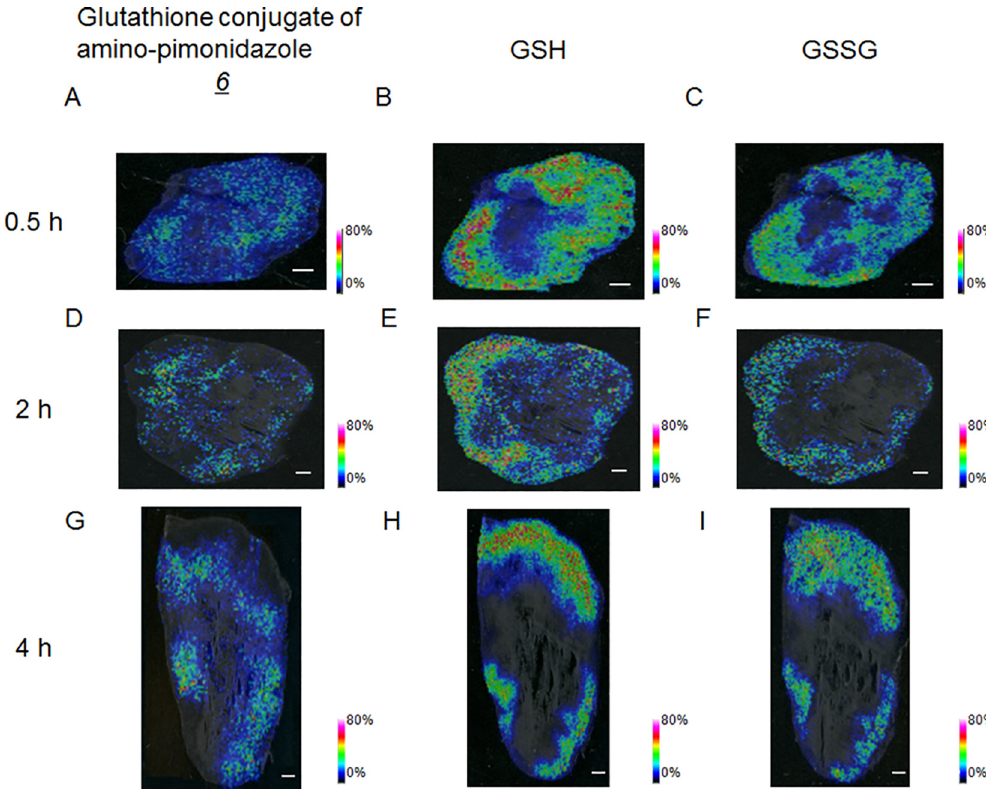
Fig 3. Representative mass spectrometric images of the glutathione conjugate of amino-pimonidazole and oxidized- and reduced glutathione in mouse tumors. The scale bar represents 1 mm. (A) – (C): Mass spectrometric images of mouse tumor 0.5 h after administration of pimonidazole. (D) – (F): Mass spectrometric images of mouse tumor 2 h after administration. (G) – (I): Mass spectrometric images of mouse tumor 4 h